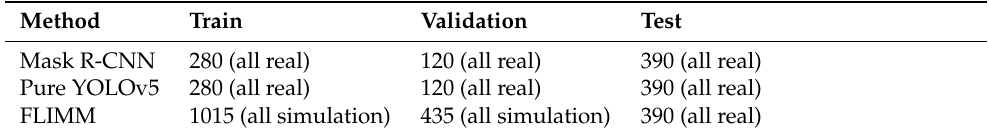
Figure 2. The augmentation results comparison ( a ) Mosaic data augmentation. ( b ) FADGAM with multi-digit augmentation mode. ( c ) FADGAM with single-digit augmentation mode. Table 1. Dataset